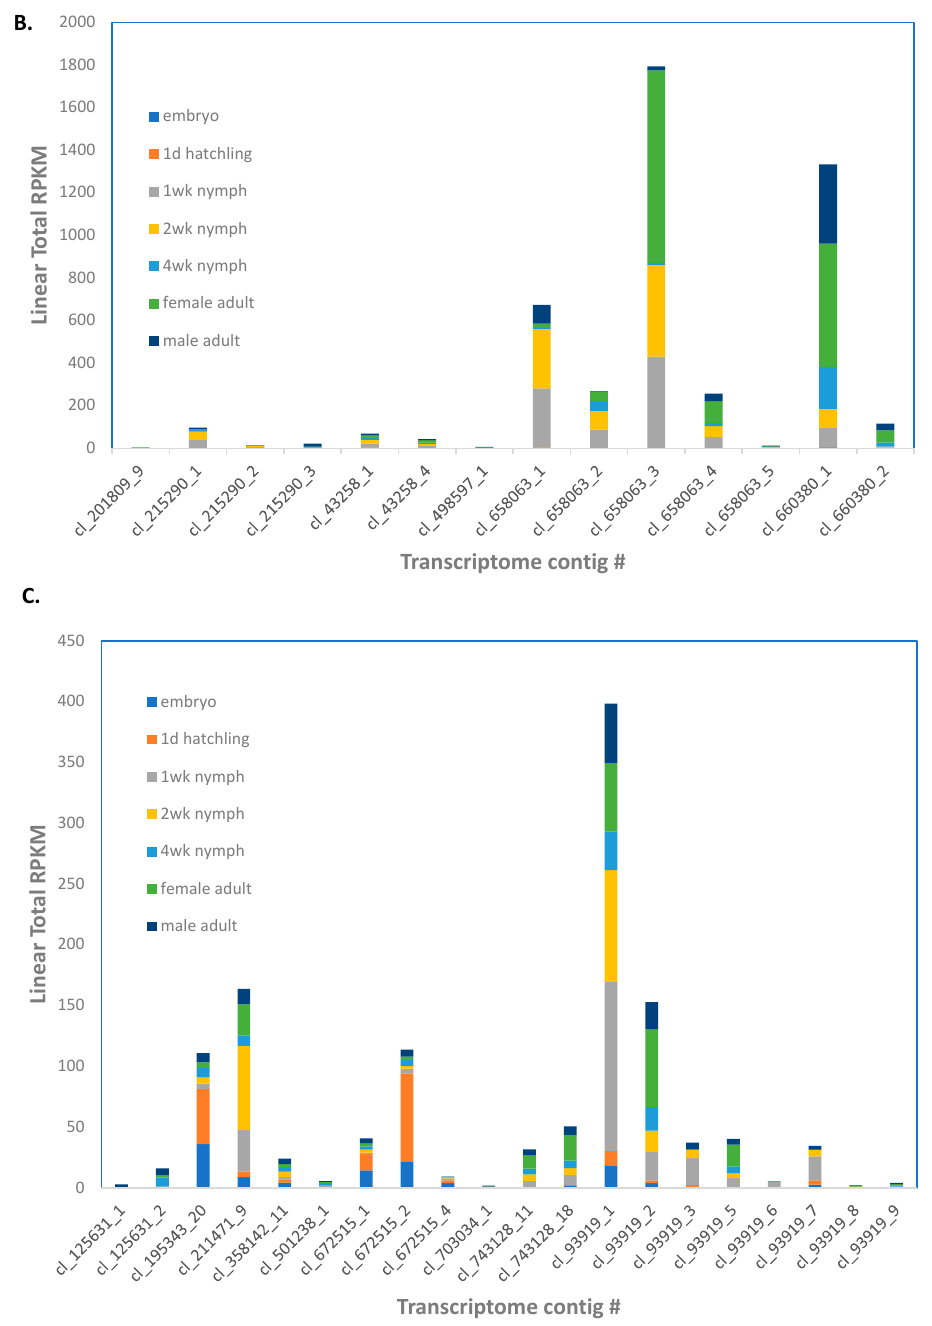
Figure 3. Expression profiles of transcripts tentatively identified as immune-related genes in A. domesticus developmental stages or male and female adults (as indicated in the legend). Transcripts were identified in a previous transcriptome assembly [22]. ( A ) GNBP; ( B ) Lysozymes; ( C ) PPO. There were four genes annotated as lysozymes in the A. domesticus assembly (File S5). Contigs cl_658063 (five isoforms) and cl_660380_1 (two isoforms) corresponding to ANN24139-RA and ANN24140-RA/ANN24139-RA, respectively, were the most highly expressed putative lysozyme transcripts in the transcriptome assembly [22]; ANN19980-RA transcripts were expressed at low levels (Figure 3B). Lysozyme transcripts were ex- pressed higher in 1 and 2 week nymphs and male and female adults. The A. domesticus genome assembly contained nine genes annotated as PPO (File S5). Contig cl_93919 (nine isoforms), corresponding to all nine genes, was more highly ex- pressed throughout life stages (Figure 3C). However, cl_672515 (three isoforms) corre- sponding to ANN15897-RA, and cl_195343 corresponding to ANN15899-RA were more highly expressed in newly hatched larvae.